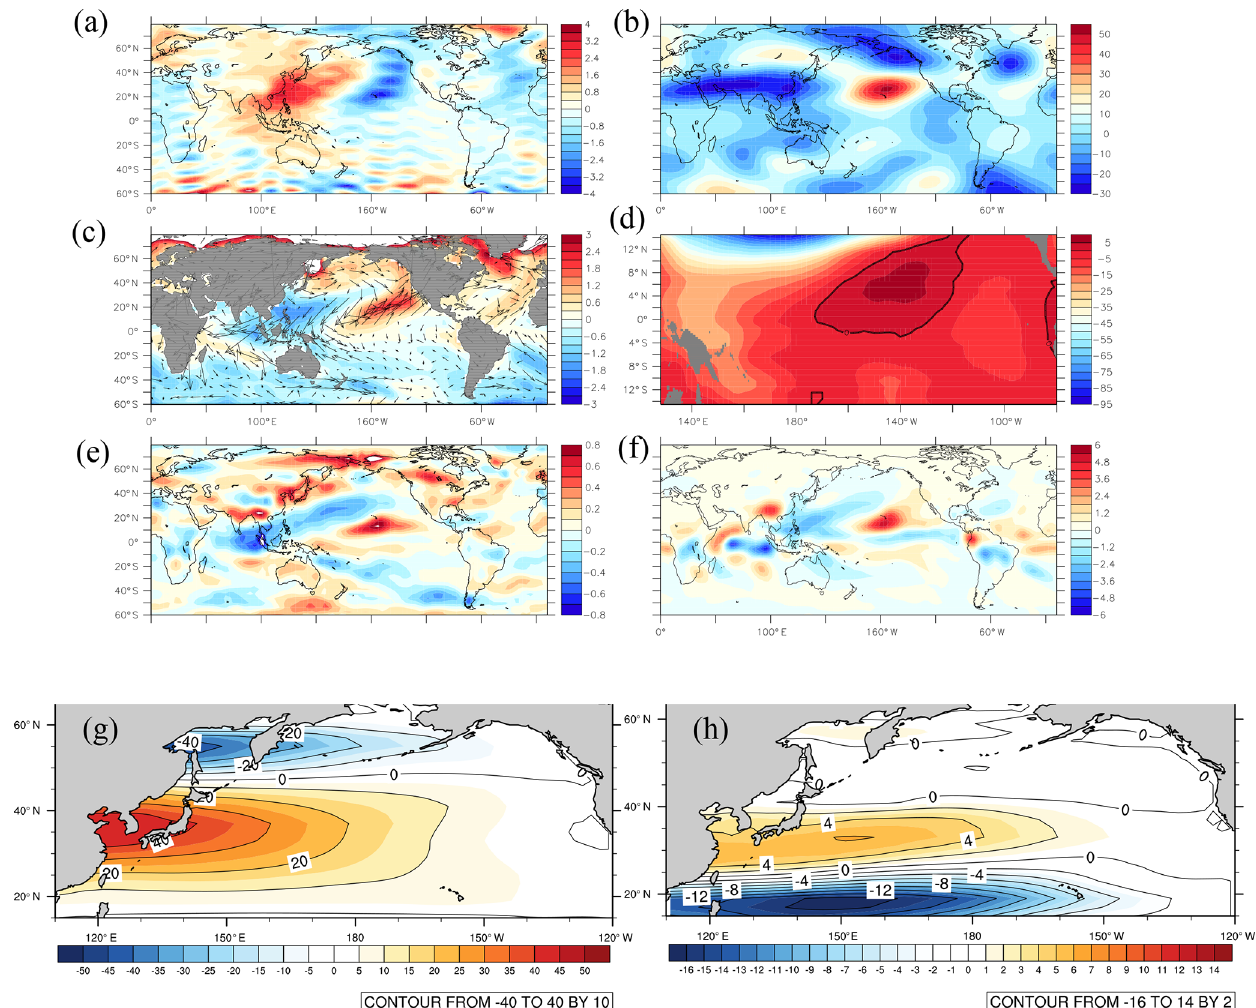
Figure 1. (a) Annual differences between MIS31 and CTR runs for SLP e and (b) for Z200 (mbar). Panel (c) shows differences in monthly SST ( ◦ C) and wind stress (vector, Nm − 2 ) between MIS31 and CTR runs. (d) Differences in thermocline depth between MIS31 and CTR simulation (meter). Panels (e) and (f) show differences between MIS31 and CTR zonal wind stress (Nm − 2 ), and precipitation differences between MIS31 and CTR runs (mmd − 1 ). Panel (g) is the Sverdrup transport in the CTR and (h) the difference between the Sverdrup transport in the MIS31 and CTR